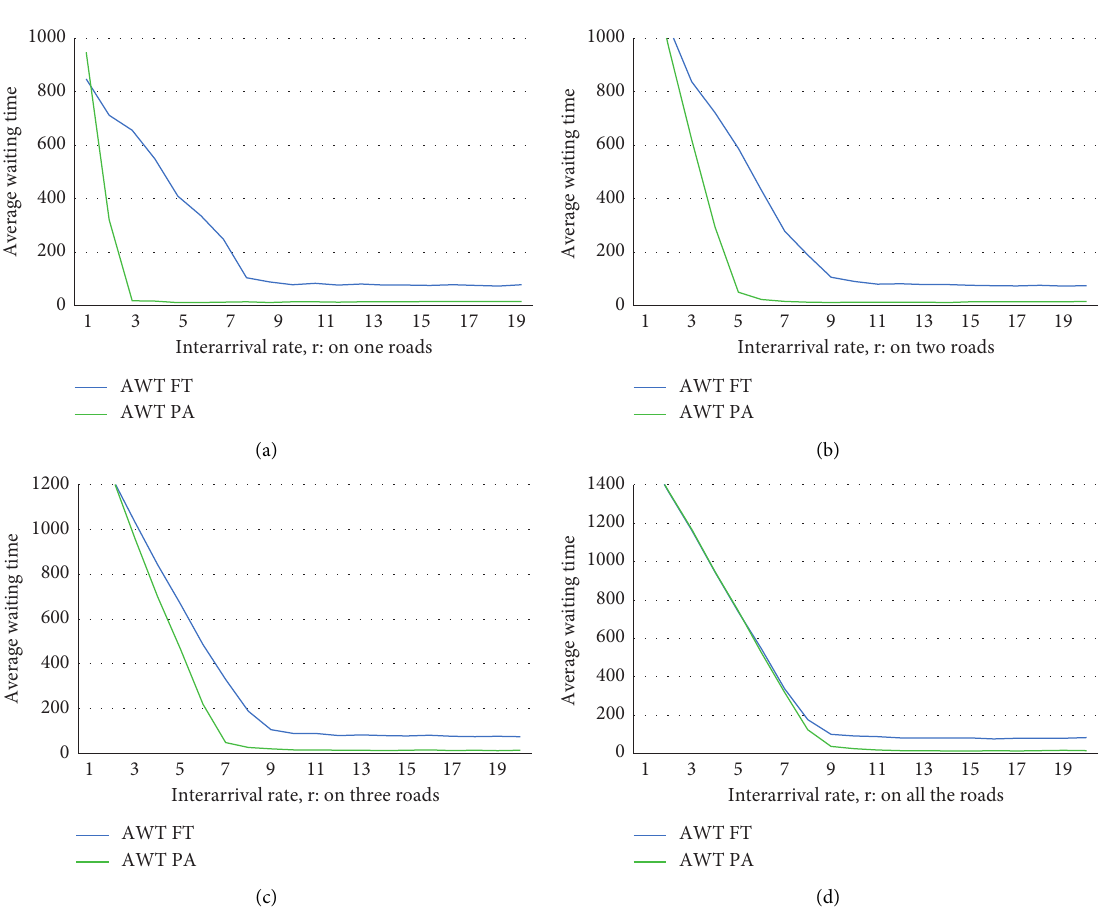
Figure 14: Average waiting time (AWT) using the fixed-time (FT) and the proposed algorithm (PA) when the road(s) has/have varying traffic density (varying r from 1 to 20) and the other road(s) has/have low traffic density (constant r:30). (a) Fixing the arrival rate on three roads and varying the rate on the fourth road. (b) Fixing the arrival rate on two roads and varying the rate on the third and fourth roads equally. (c) Fixing the arrival rate on one road and varying the rate equally on the other three roads. (d) Varying the inter-arrival rate equally on all the four